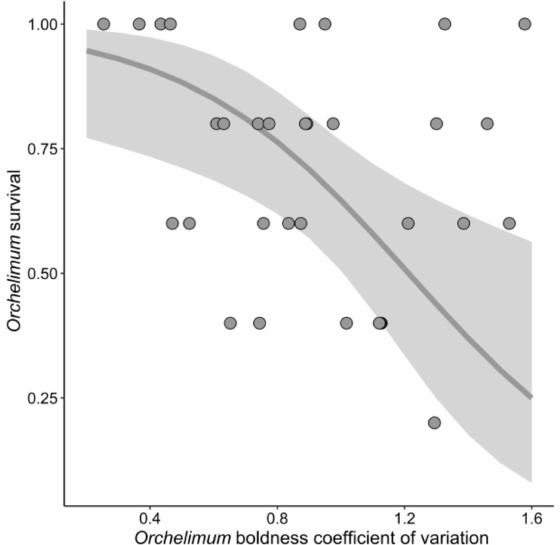
Figure 4. Direct e ff ect of Orchelimum prey boldness variance on Orchelimum proportional survival across all spider predator treatments. Field mesocosms were stocked with 5 Orchelimum individuals, and population-level boldness variance was calculated as the coe ffi cient of variation in boldness across these 5 individuals. Shaded areas around marginal e ff ect regression line represent 84% confidence intervals generated using the “ggpredict” function in the R package “gge ff ects”